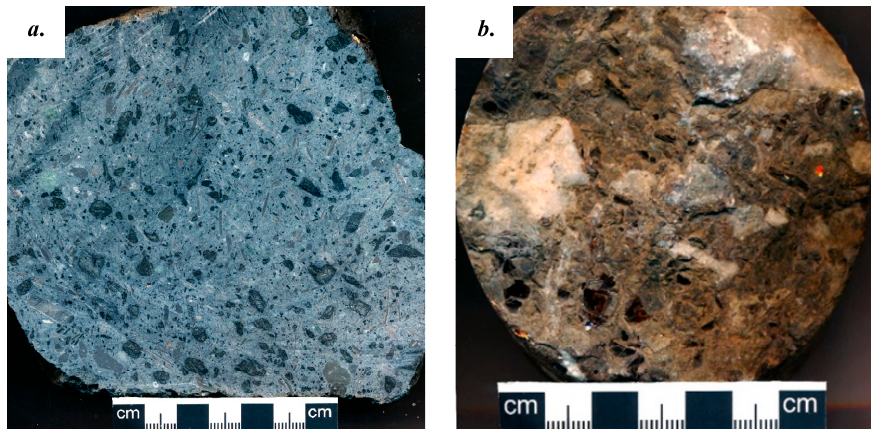
Figure 5. Scanned image of the cut sample from YuP ( a ). Photo of the of Phl aillikite breccia ( b ) with xenoliths of carbonatites.